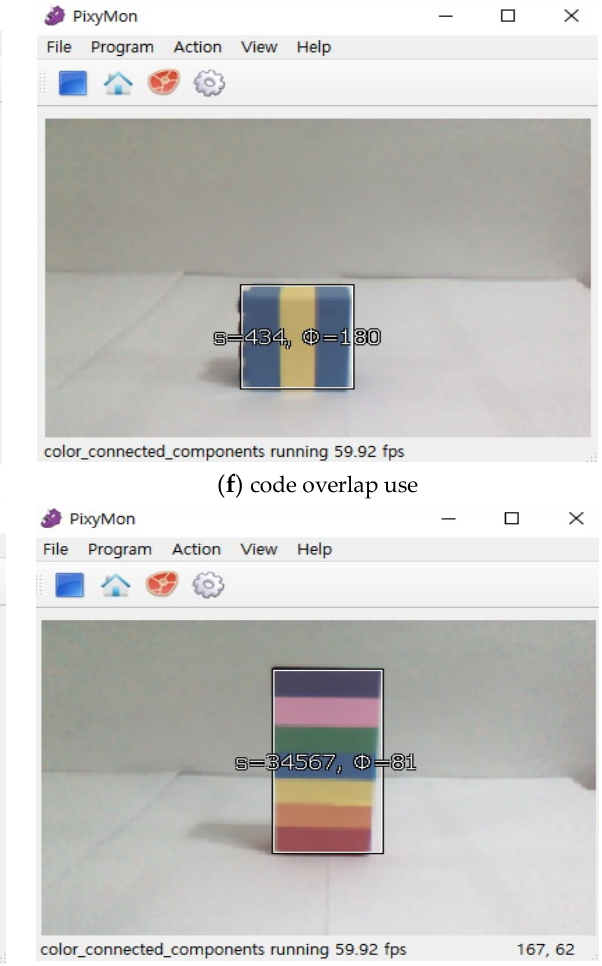
Figure 8. Color code recognition test.